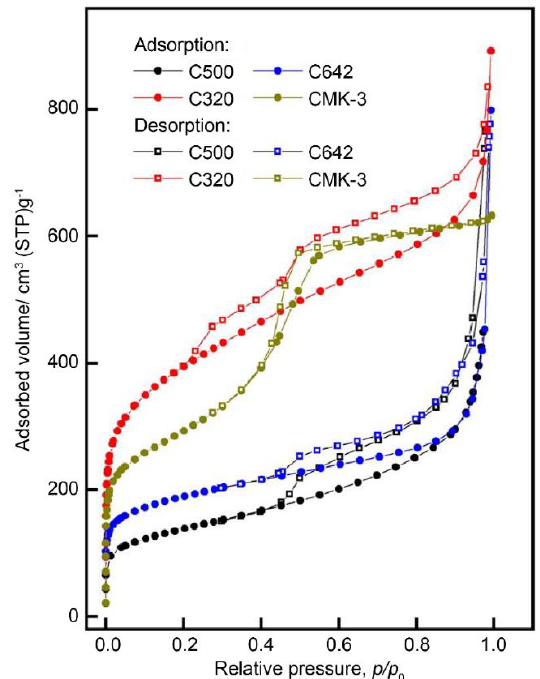
Figure 2. Nitrogen adsorption–desorption isotherms of mesoporous carbon: CMK-3, C320, C500, and C642. Table 1. Brunauer–Emmett–Teller (BET)-specific surface area, structure and pore size of mesoporous carbons.